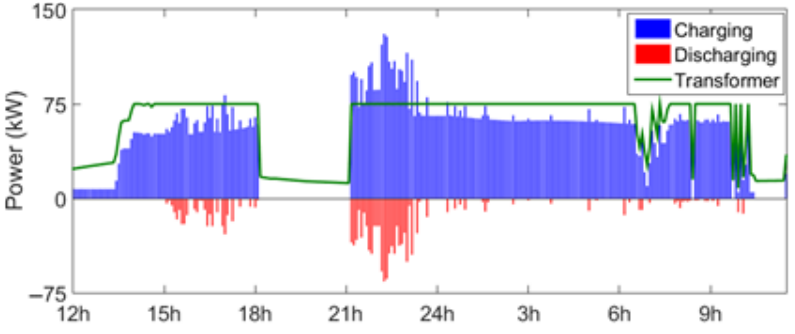
Figure 8. Scheduled dis/charging power profile.